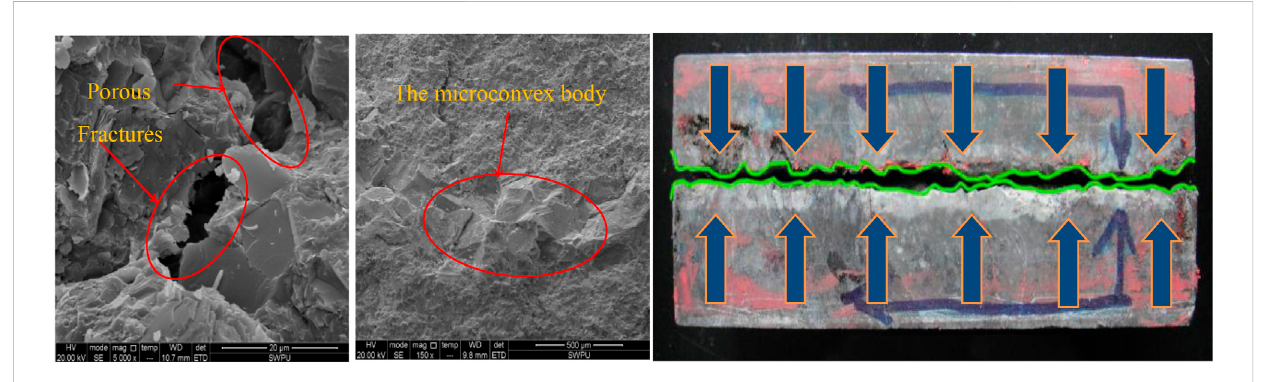
FIGURE 10 SEM photograph of fractures, pores and